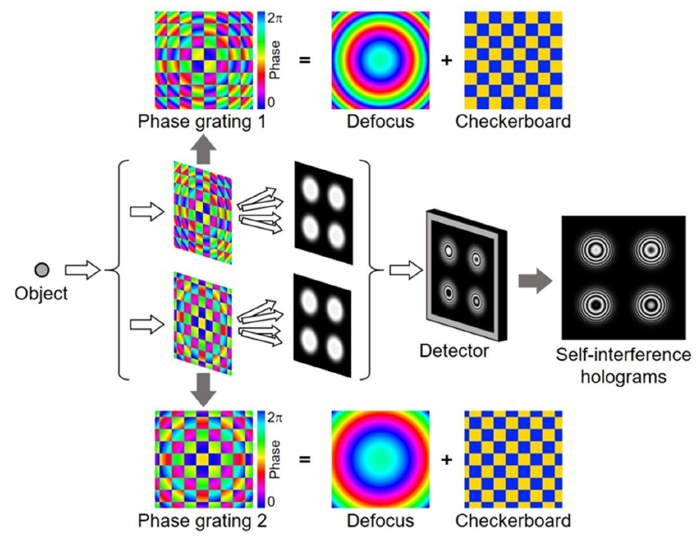
Figure 2. Schematic of single-phot phase-shifting FINCH with dual-phase gratings.